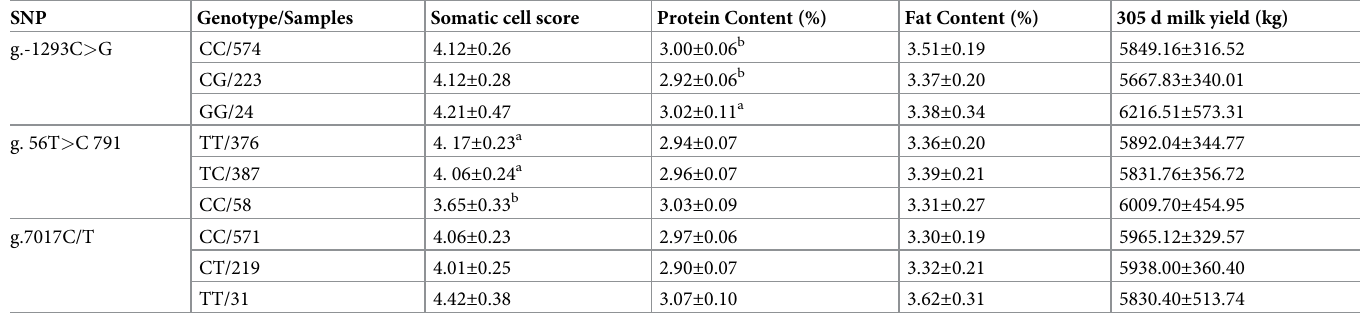
Table 6. Least squares mean (LSM) and standard errors (SE) for SCS, fat, protein rate and milk yield of different C3 genotypes in 821 Chinese Holstein. SNP